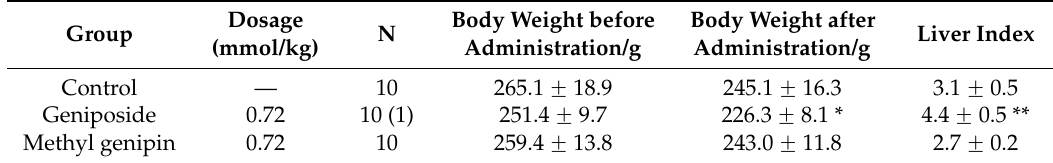
Table 1. Effects of GE or MG on body weight and liver index after oral administration in rats.